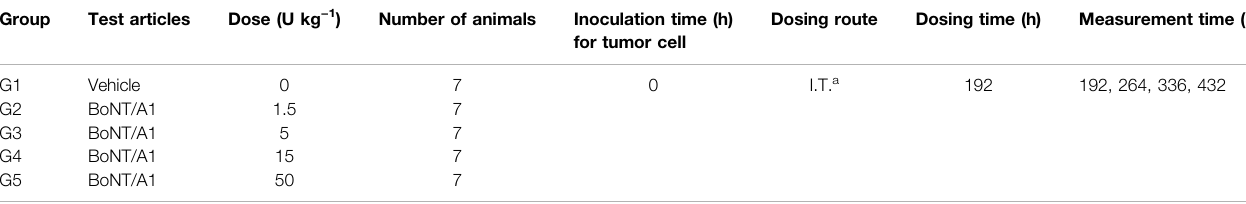
TABLE 1 | Study design for tumor growth inhibition using a syngeneic melanoma mouse model.